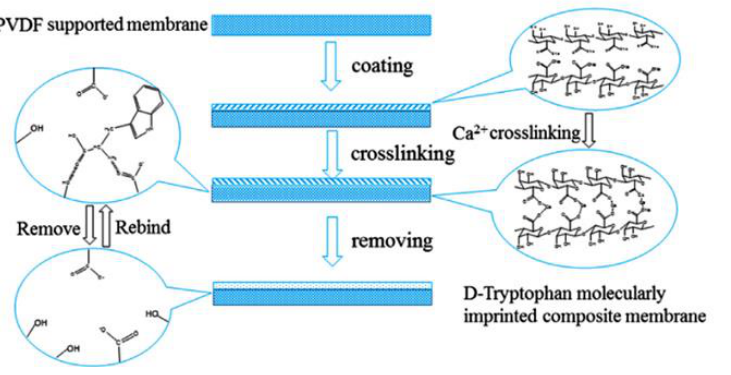
Figure 12. Illustration of the preparation process of composite d-tryptophan-sodium alginate/ poly (vinylidene) fluoride imprinted membrane. (Reprinted with permission from Ref. [254]. Copyright 2017 Elsevier.)